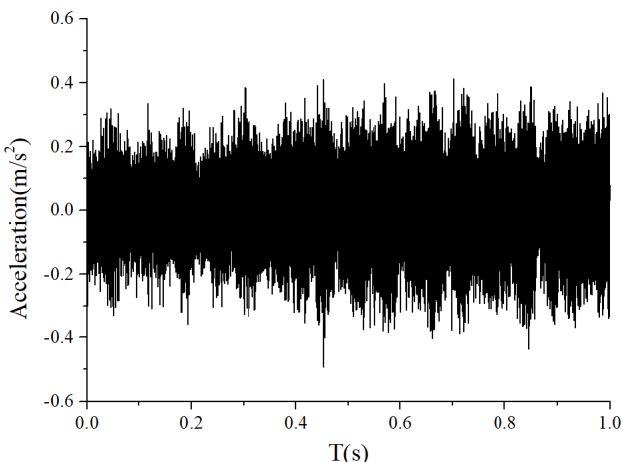
Figure 36. Acceleration waveform (slight friction). Figure 36. The time-domain waveform of the test signal (slight